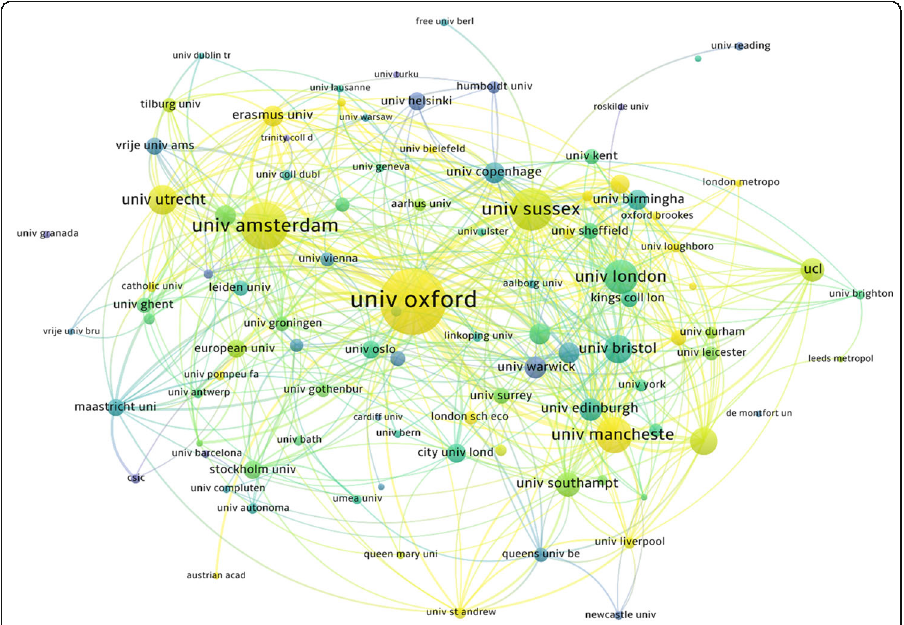
Fig. 2 Citation map of migration research by European organisations (2004-2018). Bigger nodes denote more publications. Brighter (yellow) nodes denote more citations